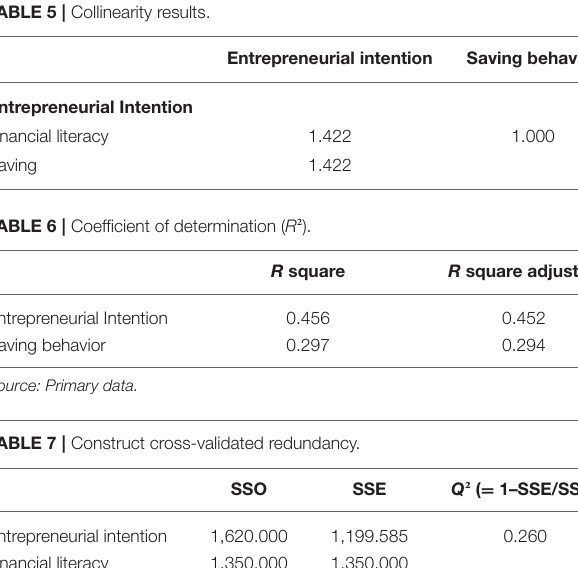
TABLE 3 | Reliability and convergent validity.